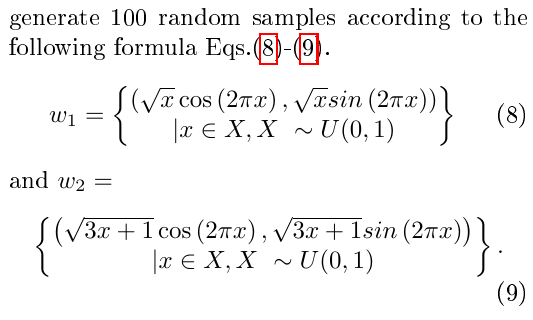
Fig. 2: Boosted Gaussian Na(cid:239)ve Bayes Algorithm.